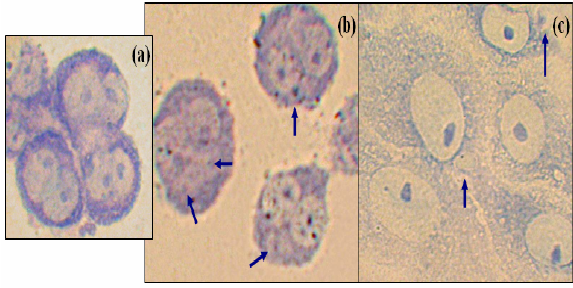
Figure 1: (a) Control cells 24h following the addition of Cytochalasin B showing binucleated cells, (400X), (b) MN in binucleated cells treated by Domoic acid, (100 ng/ml); (c) MN in mononucleated cells treated by okadaic acid, (60 ng/ml). Cells are stained with Giemsa (arrows indicate micronuclei) Table 1: Number of Micronuclei (MN) in mono and Binucleate Caco-2 cells (1000 cells counted)